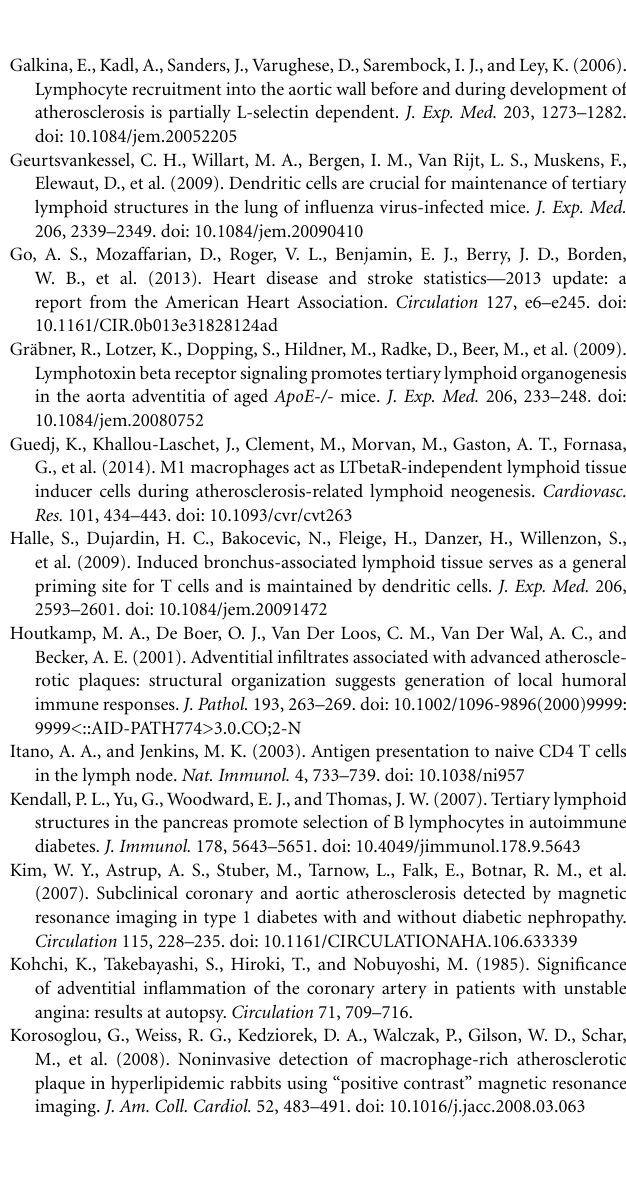
in VSMCs. Activated VSMCs express lymphorganogenic chemokines such as CCL19, CCL21, CXCL13, and CXCL16, thereby orchestrating ATLO neogenesis and developement. I, Intima; M, Media; A,